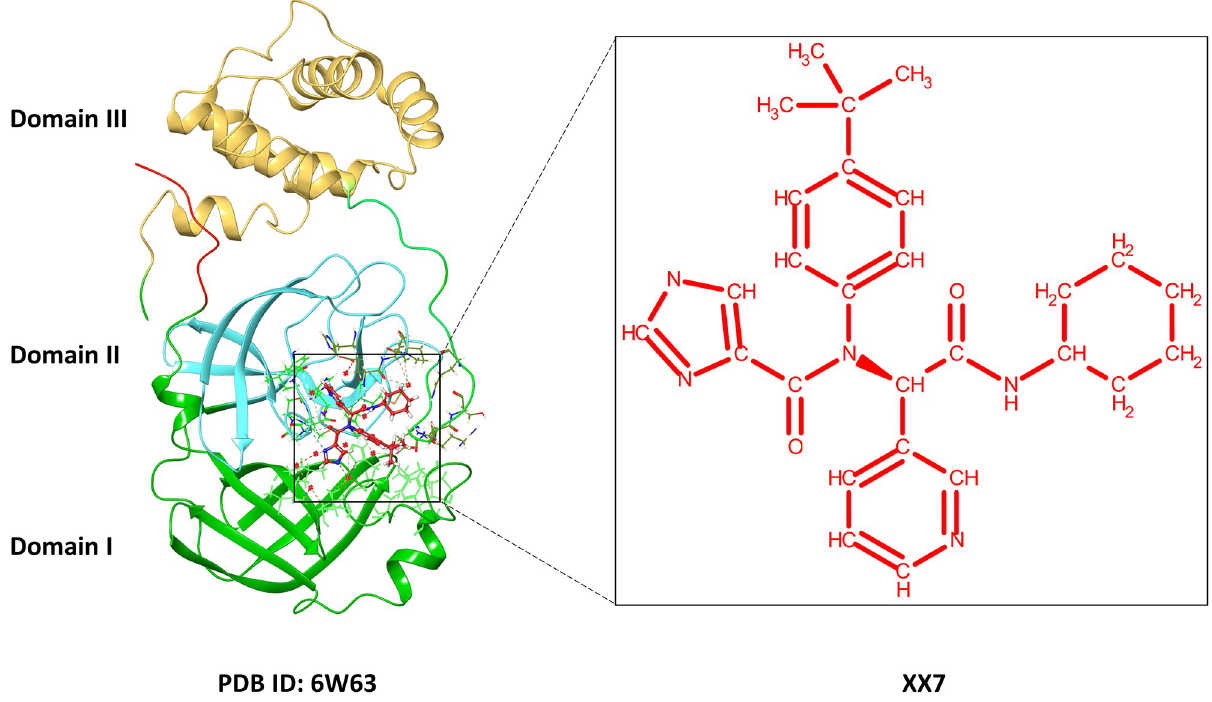
Fig 1. Crystal structure of M pro (PDB ID: 6W63) representing Domain I, II and III with the co-crystalized ligand (PDB code: X77).